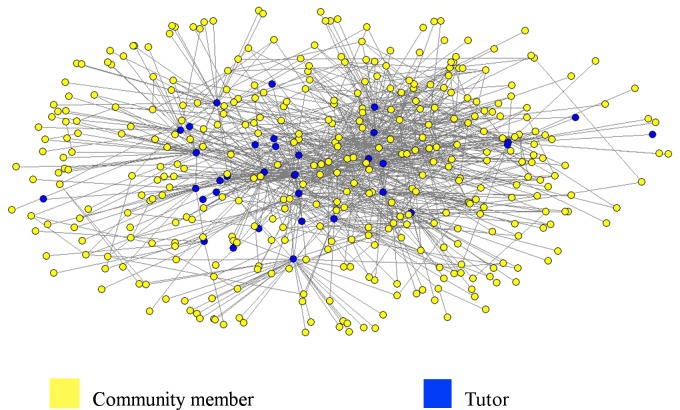
Network of Cluster ID-3 (Louvain method).